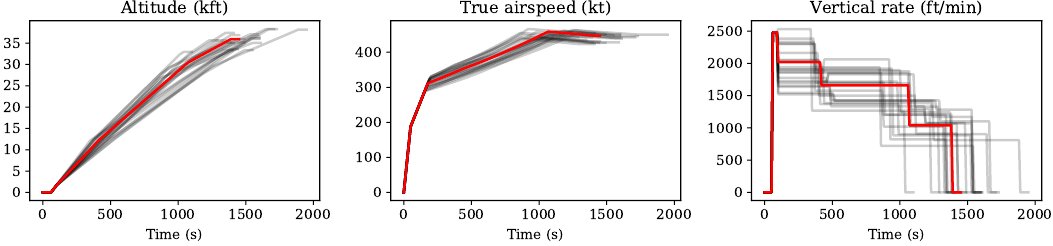
Figure 7. Generated climbing trajectory (Airbus